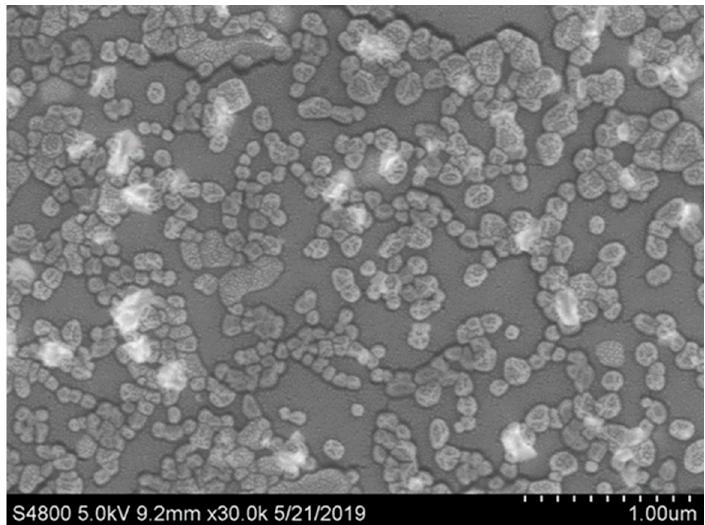
Figure 6. SEM image of cholic conjugated chitosan derivative 2.